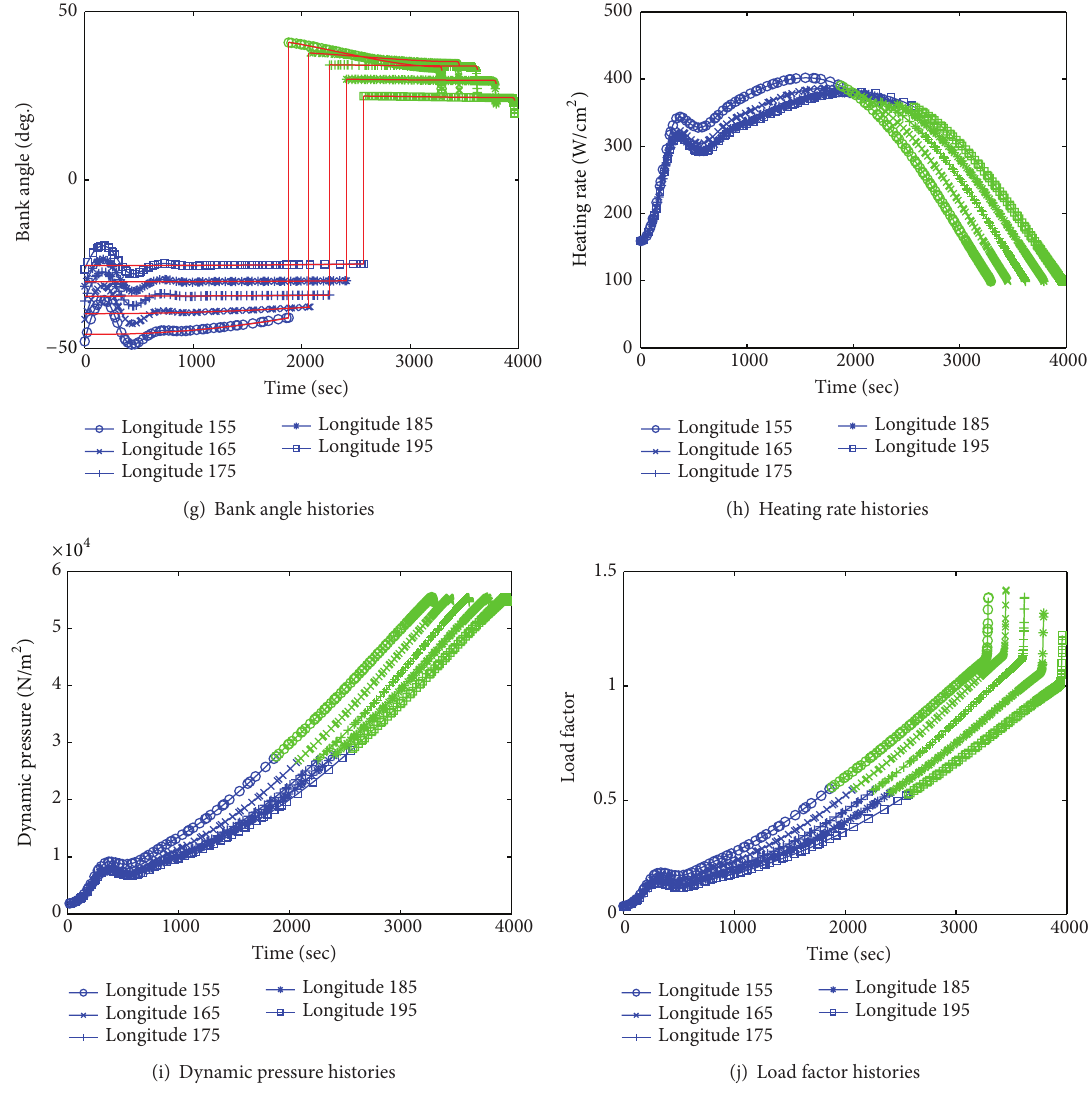
Figure 5: Numeric results of Steady Glide Trajectory Optimization with Bank Reversal.